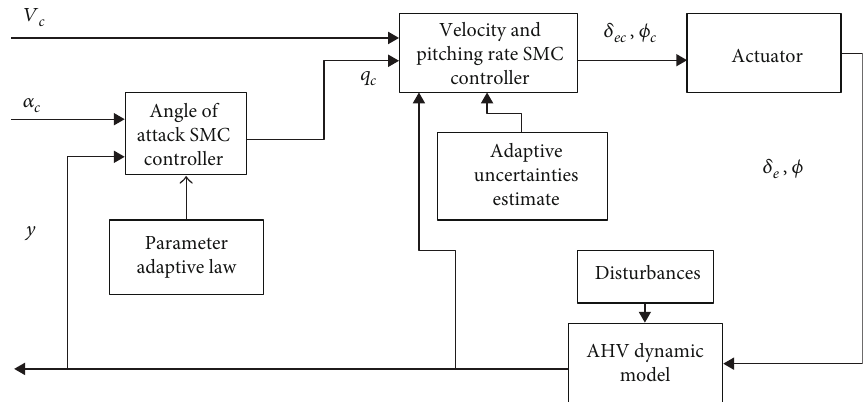
Figure 1: AHV adaptive nonsingular terminal sliding mode control block